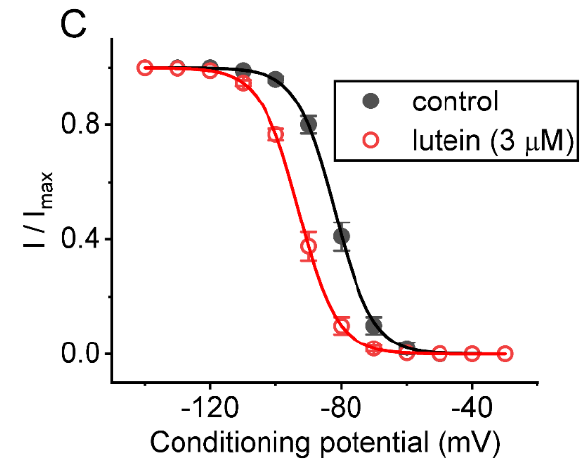
Figure 2. Inhibitory effect of lutein on average current versus voltage (I – V ) relationship ( A , B ) and steady-state activation curve (C) of I h recorded from GH 3 cells. In this set of measurements, experimental protocols are the same as those appearing in Figure 1. ( A ) Representative current traces acquired in the absence (upper) and presence of 3 μM lutein (lower). The uppermost part points to the voltage-clamp profile imposed over the tested cell. Potential traces shown in different colors correspond with ionic currents that were evoked by the same level of step voltages. ( B ) Average I–V relationship of I h acquired in the absence ( ■ ) or presence ( □ ) of 3 μM lutein (mean ± SEM; n = 7 for each point). ( C ) Modifications of lutein (3 μM) on the quasi-steady-state activation curve of I h seen in GH 3 cells. Continuous sigmoidal curves drawn were optimized with the chi-square test of goodness of fit according to a modified Boltzmann function as detailed in the Section 4. Each data point is the mean ± SEM ( n = 7). ● : control; ○ : in the presence of 3 μM lutein. Of note is the leftward shift along the voltage axis in the steady-state activation curve of I h during cell exposure to lutein.